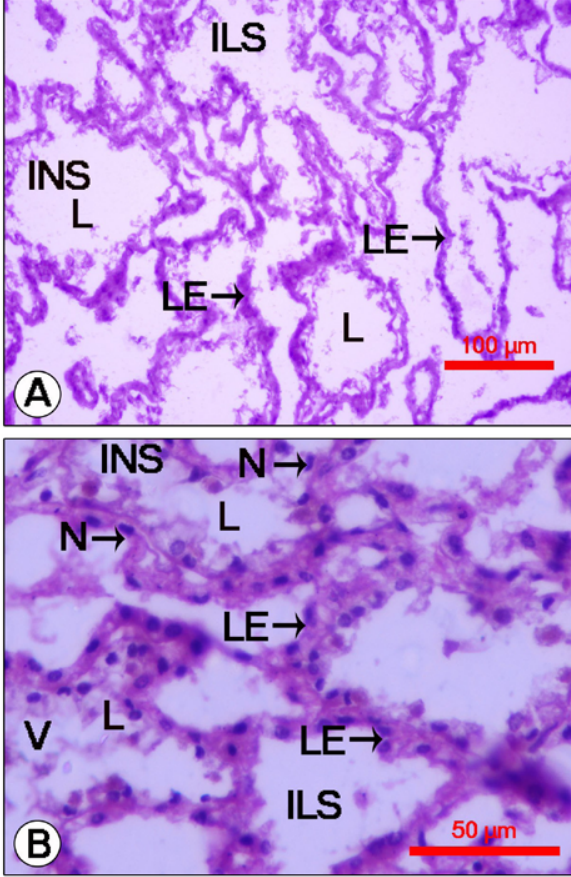
Figure 10. Light micrograph of histology of control Y-organ during early postmoult stage in Travancoriana schirnerae. ( A ) Y-organ displaying small, loosely arranged lobules and conspicuous intra- and inter-lobular spaces showing signs of inactivity. ( B ) Thin, discontinuous lobular epithelium with pycnotic nuclei. ILS: Inter- lobular space; INS: Intra-lobular space; L: Lobule; LE: Lobular epithelium; N: Pycnotic nuclei; V: